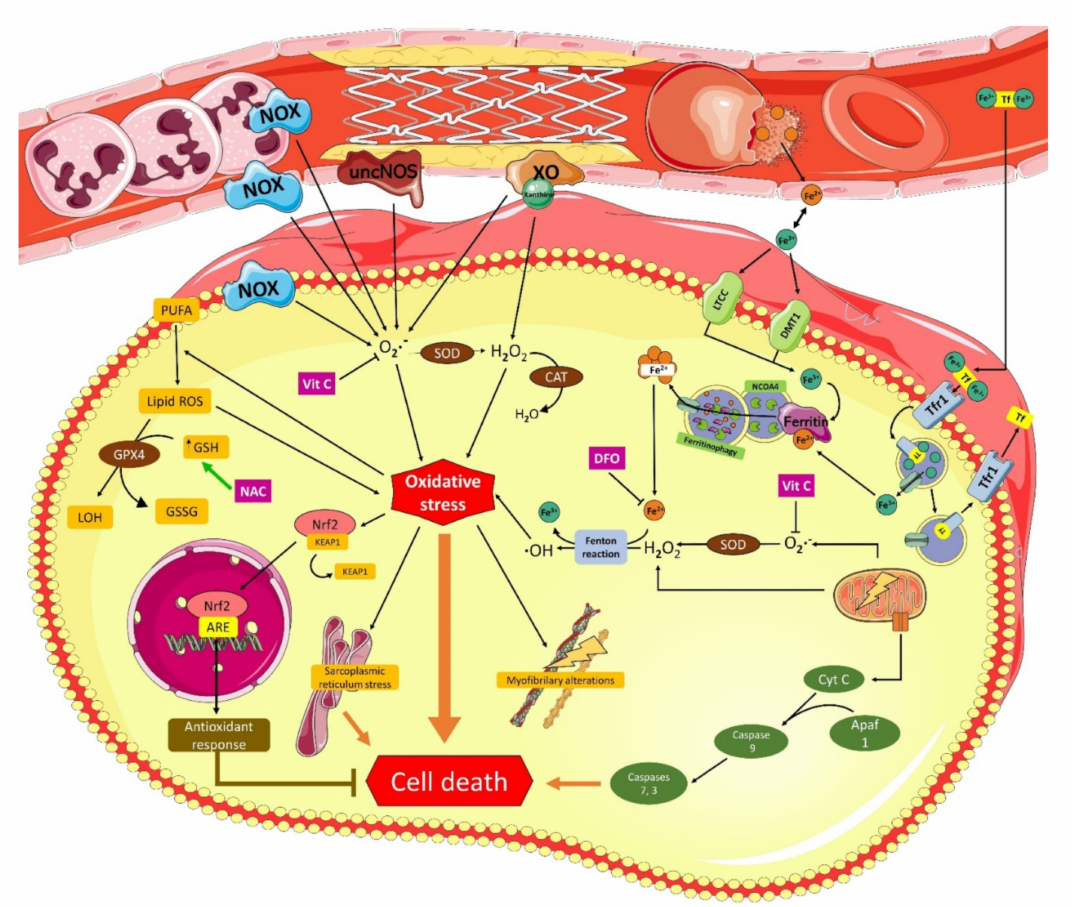
Figure 1. Molecular mechanisms of the deleterious effects of myocardial reperfusion injury and proposed target of combined antioxidant therapy: Apaf1, apoptosis protease-activating factor-1; ARE, antioxidant response element; CAT, catalase; Cyt C, cytochrome c; DFO, deferoxamine; DMT1, divalent metal transporter 1; GPX, glutathione peroxidase; GSH, reduced glutathione; GSSG, oxidized glutathione; KEAP1, Kelch-like ECH-associated protein 1; LTCC, L-type calcium channel; LOH, lipid alcohols; NAC, N-acetyl-L-cysteine; NCOA4, nuclear receptor coactivator 4; Nrf2, nuclear factor-erythroid 2-related factor 2; NOX, reduced nicotinamide adenine dinucleotide phosphate oxidase; PUFA, polyunsaturated fatty acids; ROS, reactive oxygen species; SOD, superoxide dismutase; Tf, transferrin; TfR1, transferrin receptor protein 1; Vit C, vitamin C; XO, xanthine